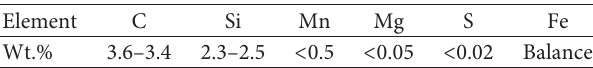
Table 4: Chemical composition of the melt used in this